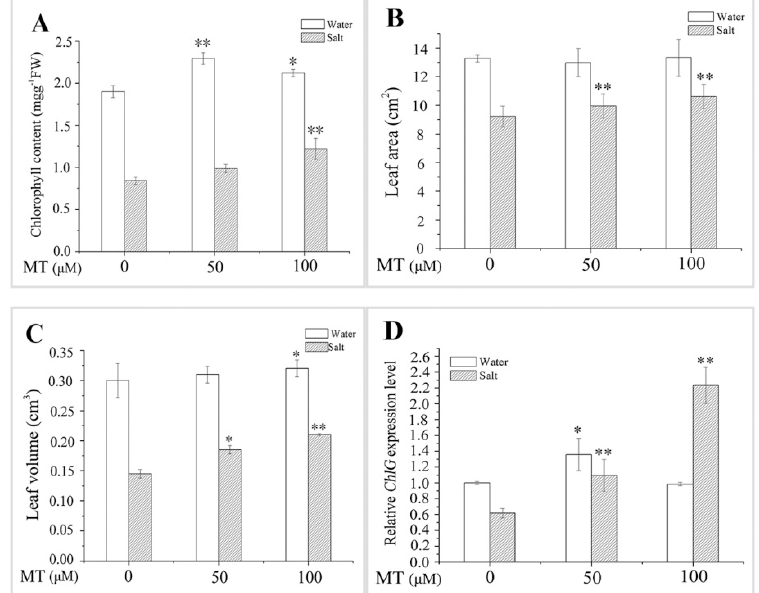
Figure 3. Effect of pretreating with different concentrations of melatonin (MT) on growth of leaves of naked oat seedlings under salt stress. ( A ) Chlorophyll content; ( B ) leaf area; ( C ) leaf volume; ( D ) relative chlorophyll biosynthase gene ( ChlG ) expression level. Values are mean ± standard deviation ( n = 3). 0, 50, and 100 represent MT concentration ( µ M) in Figure 3. Asterisks; * and ** indicate significant difference ( p < 0.05 and p < 0.01, respectively) compared with mock coating (0 µ M). Measurement was carried out after six days of the salt plus MT pretreatmemt.